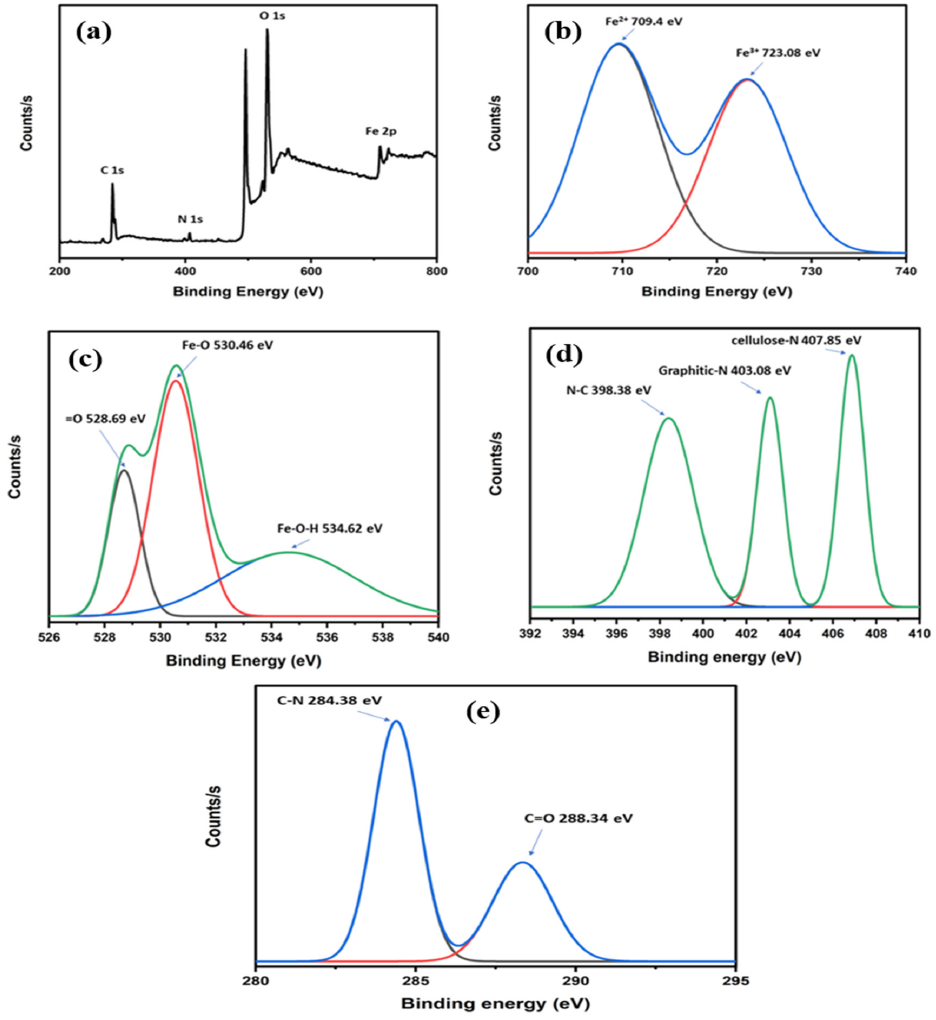
Figure 4. ( a ) XPS spectrum of biosynthesized IONPs, ( b ) Fe 2p spectra, ( c ) O 1s spectra, ( d ) N 1s spectra, and ( e ) C 1s spectra.